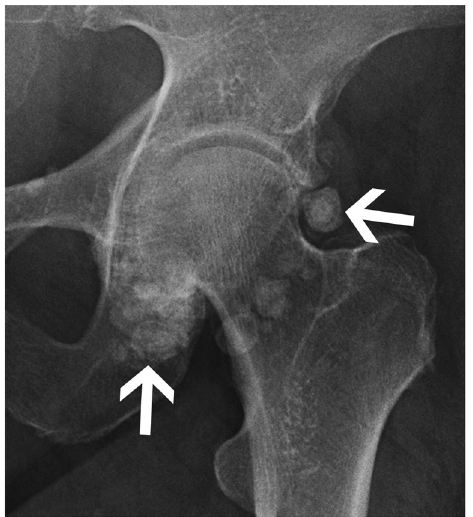
Fig. 17 Synovial osteochondromatosis. Anteroposterior radiograph of the left hip shows multiple intra-articular osteocartilaginous bodies (arrows) with ring-like calcifications centred on the coxofemoral joint